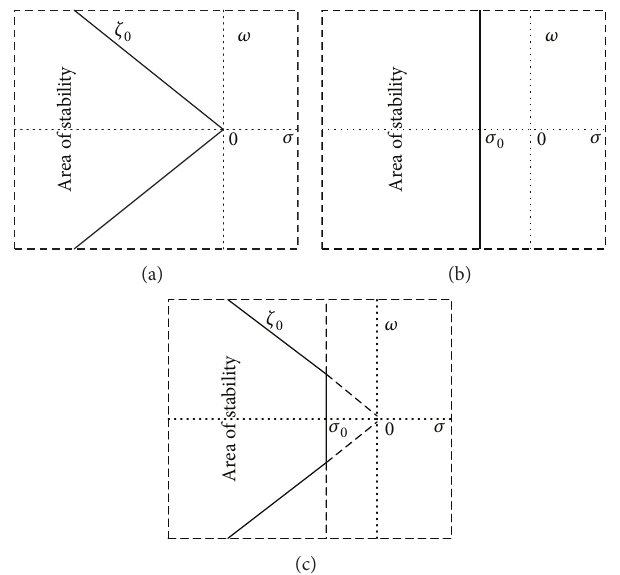
Figure 3: Stability regions defined by different objective functions in